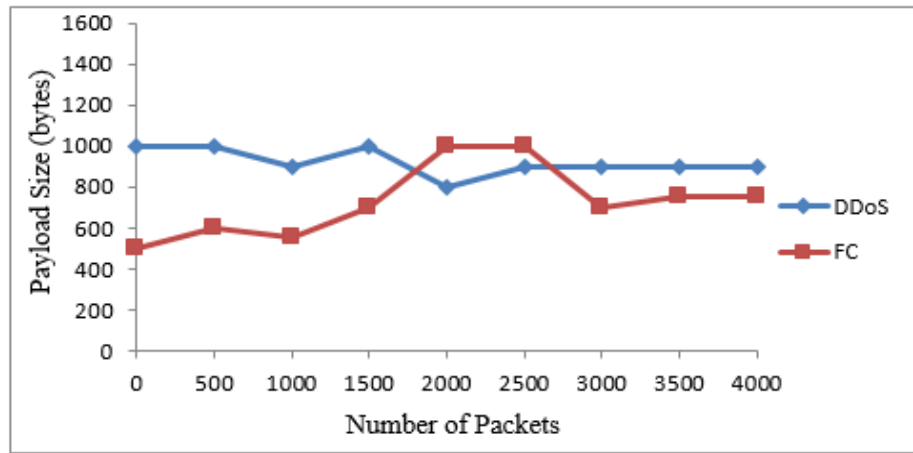
Figure 10. Discrimination of DDoS attack from FC based on the size of